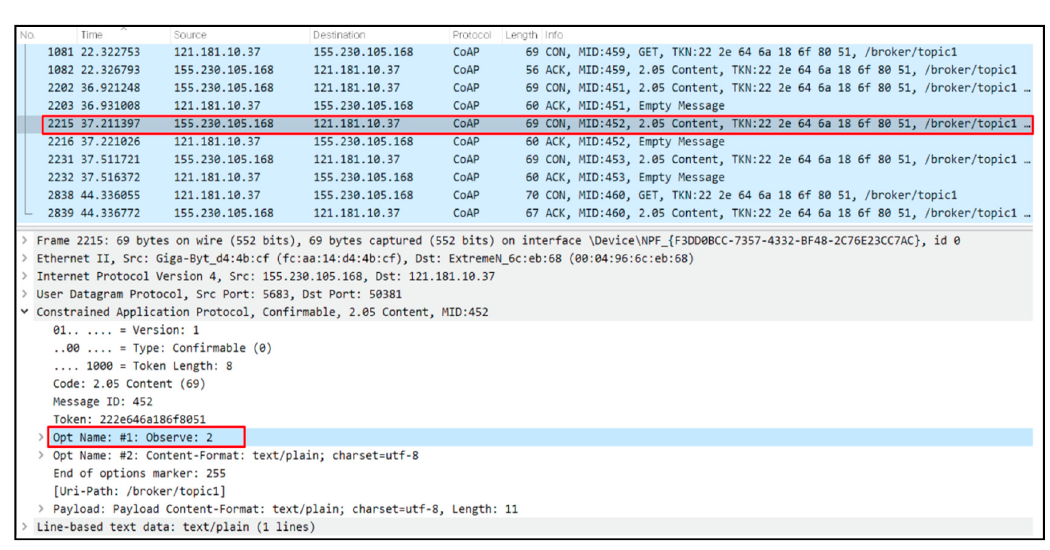
Figure 4. Packet analysis for CoAP-Observe in CoAP over UDP.